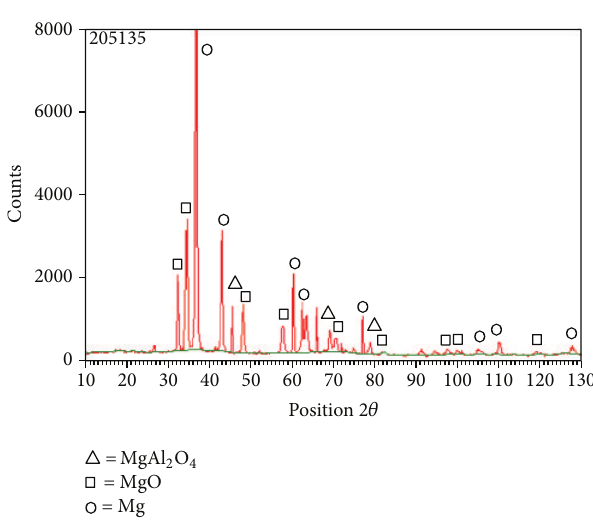
Figure 12: XRD pattern of black